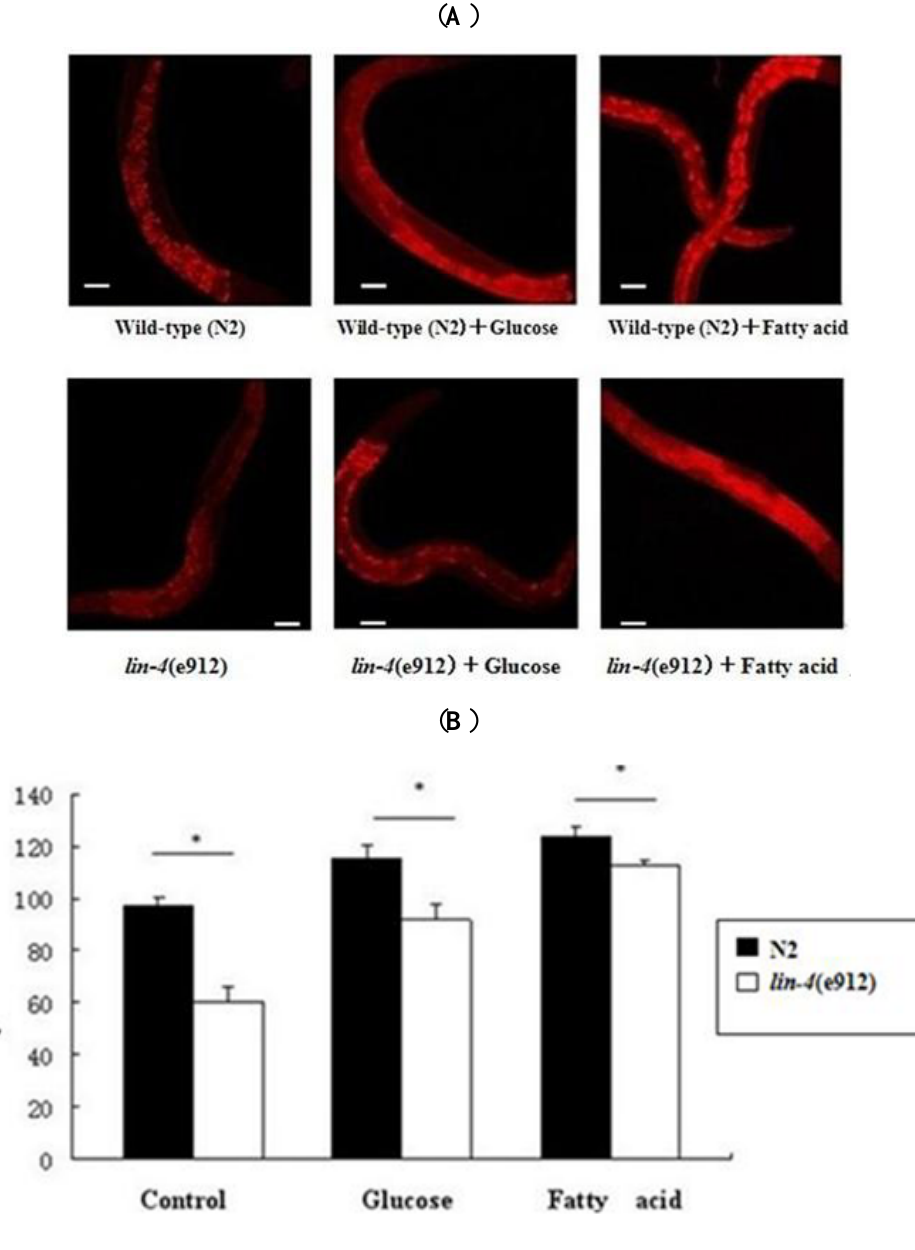
Figure 1. lin-4 regulates fat storage. ( A ) Nile red staining of wild-type (N2) and lin-4 mutant (e912) worms fed a normal diet of E. coli OP50 bacteria (left panel) or OP50 bacteria supplemented with glucose (middle) or fatty acid (right). Scale bar: 50 μm. n = 40 ( n : number); ( B ) Quantification of the Nile red staining of fat in wild-type (N2) and lin-4 mutant (e912) worms. n = 40. Error bars indicate standard error. * p <